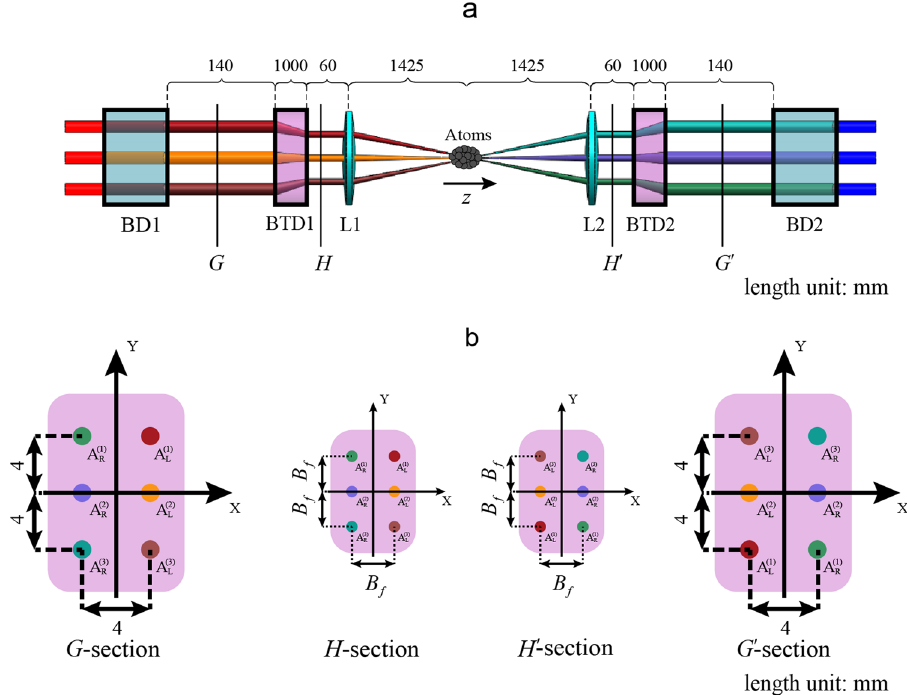
Fig. 5 Con fi guration of the PI (polarization interferometer) and cross sections of the array at different sites. a Con fi guration of the PI. b Cross section of the array at G, H, H ’ , and G ’ sites, where B f = 2 mm.